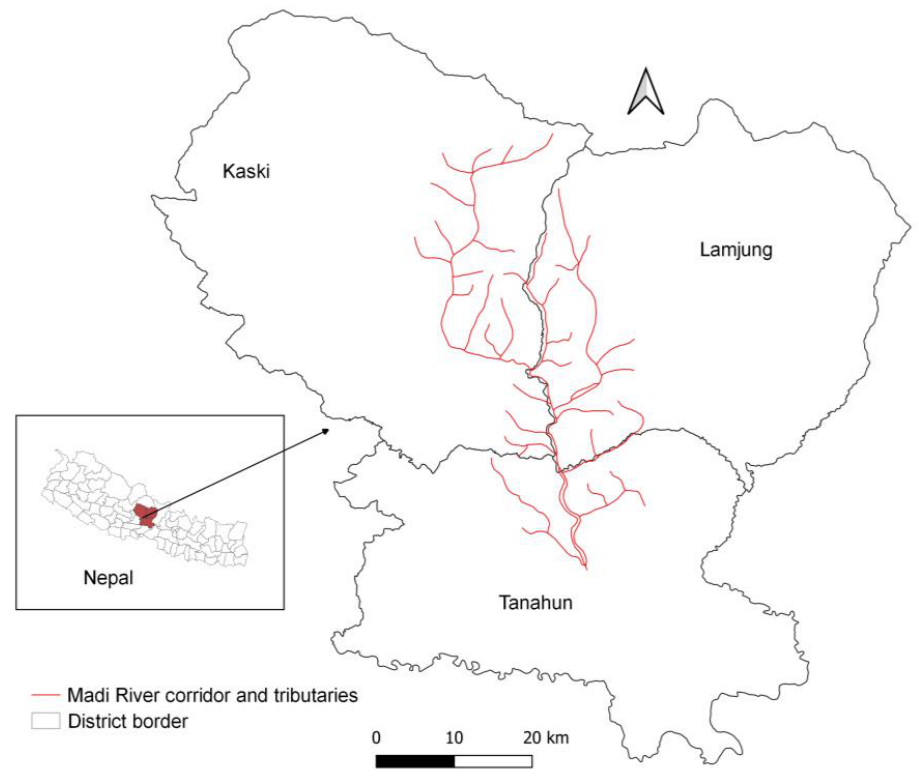
Figure 1. Madi River corridor and tributaries where field study was carried out after identifying potential suitable nesting habitat of Egyptian vultures in Tanahun, Kaski, and Lamjung districts, Nepal.